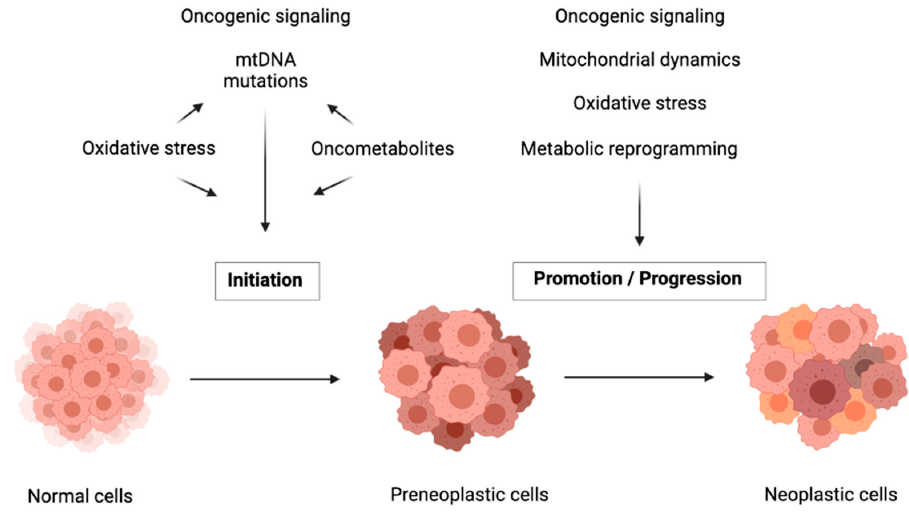
Figure 2. Carcinogenesis is a multistep process to which mitochondria contribute in various ways. Mitochondrial gene mutations are crucial for tumor initiation and mitochondrial-driven regulation of metabolic reprogramming is necessary for tumor promotion and progression.